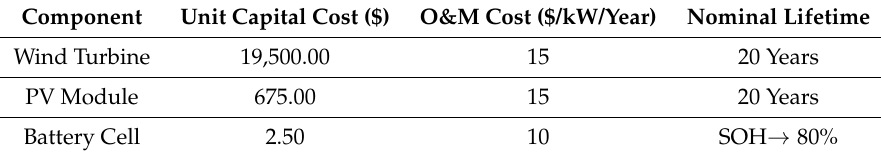
Table 2. Initial capital cost and nominal lifetime of EES